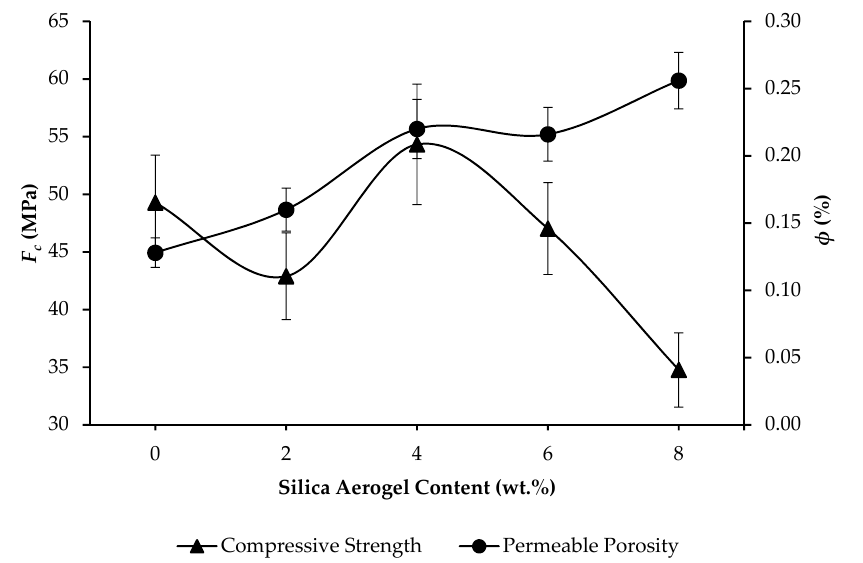
Figure 7. Compressive strength ( F c ) and permeable porosity ( ϕ ) of the composite cement paste after 28 days of curing.